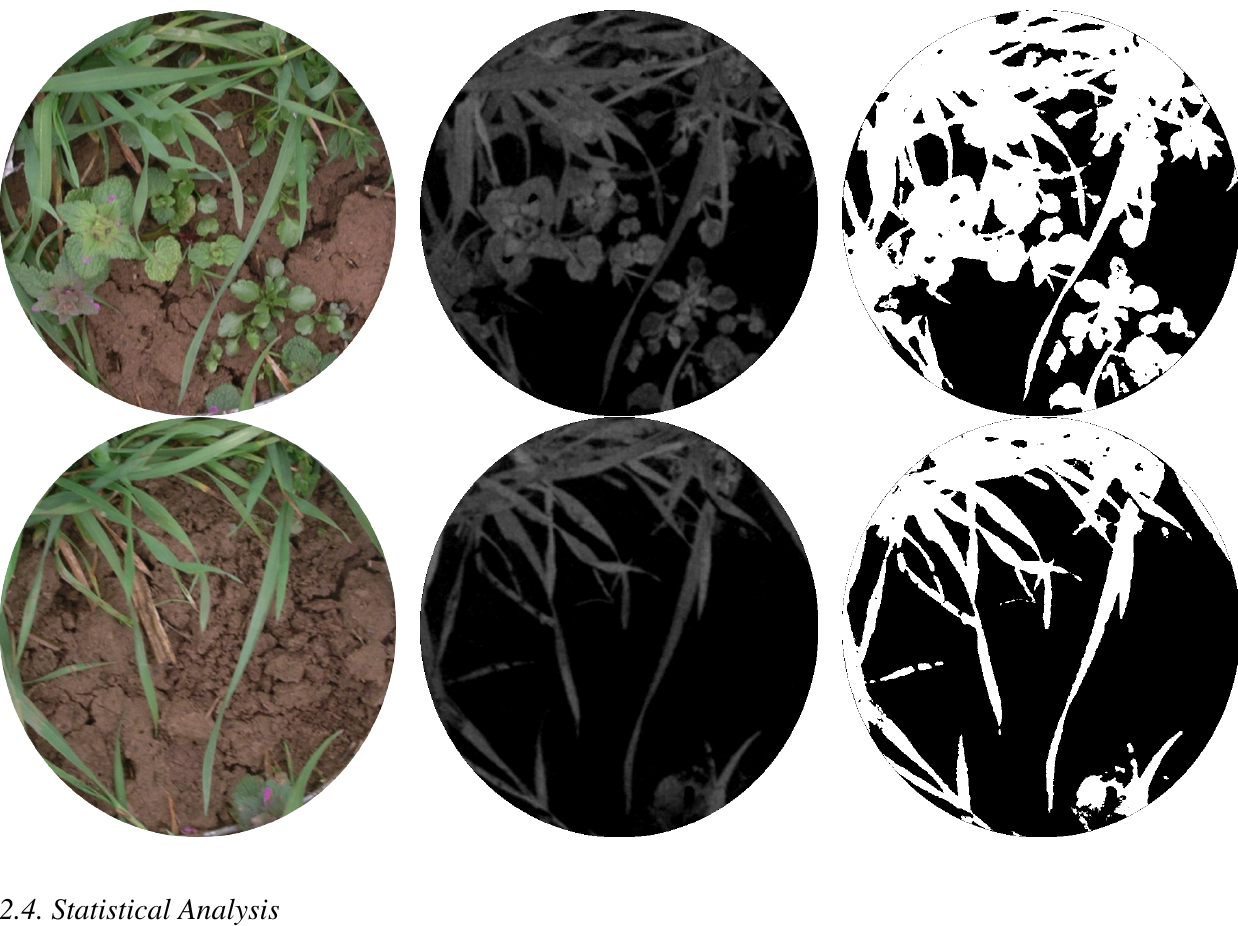
Figure 4. Process of image analysis before (top) and after weed harvesting (bottom). RGB images (left); ExG (Excess green) images (centre) and thresholded images (right) for coverage